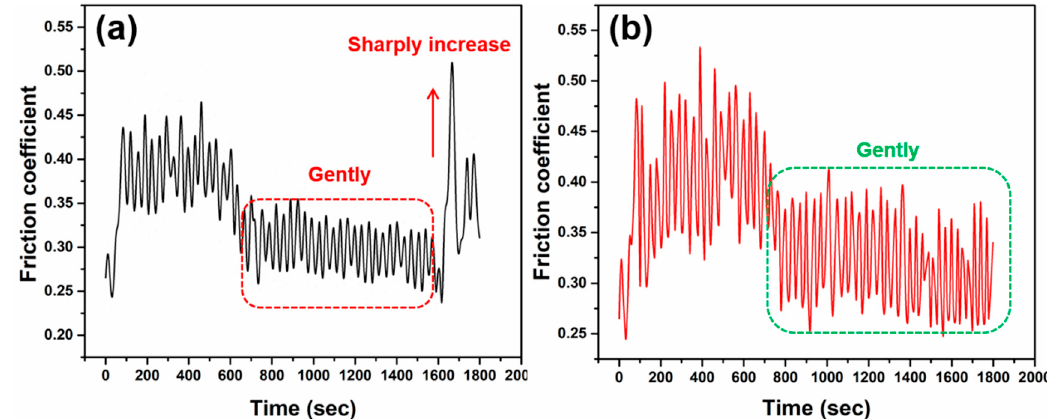
Figure 10. Variation of the friction coefficient of samples sintered by ( a ) CPS (900 °C, 395 MPa, 30 min). ( b ) MPS (900 °C, 395 MPa, 30 min).